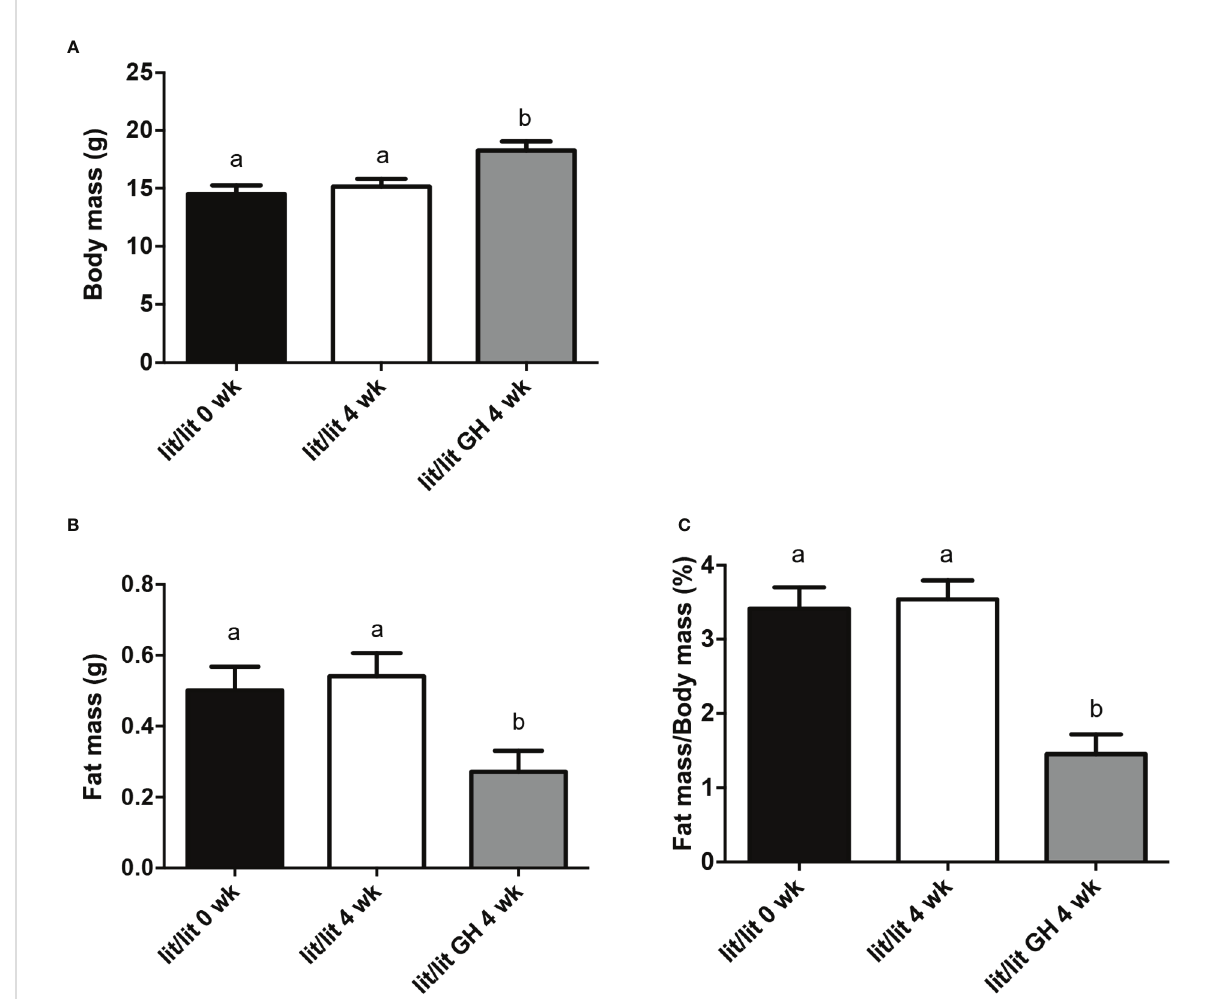
FIGURE 3 Body mass and inguinal subcutaneous fat mass of lit/lit mice before and after GH injection. Body mass and mass of inguinal subcutaneous fat pads were recorded from three groups of mice: 17-week-old lit/lit mice (indicated as lit/lit 0 wk in the graphs), 21-week-old lit/lit mice injected with GH for 4 weeks (indicated as lit/lit GH 4 wk in the graphs), and 21-week-old lit/lit mice injected with control for 4 weeks (indicated as lit/lit 4 wk in the graphs). (A) Body mass. (B) Fat mass. (C) Fat mass as percentage of body mass. Data are expressed as means ± SEM (n = 4 mice). Means labeled with different letters are statistically different ( P <